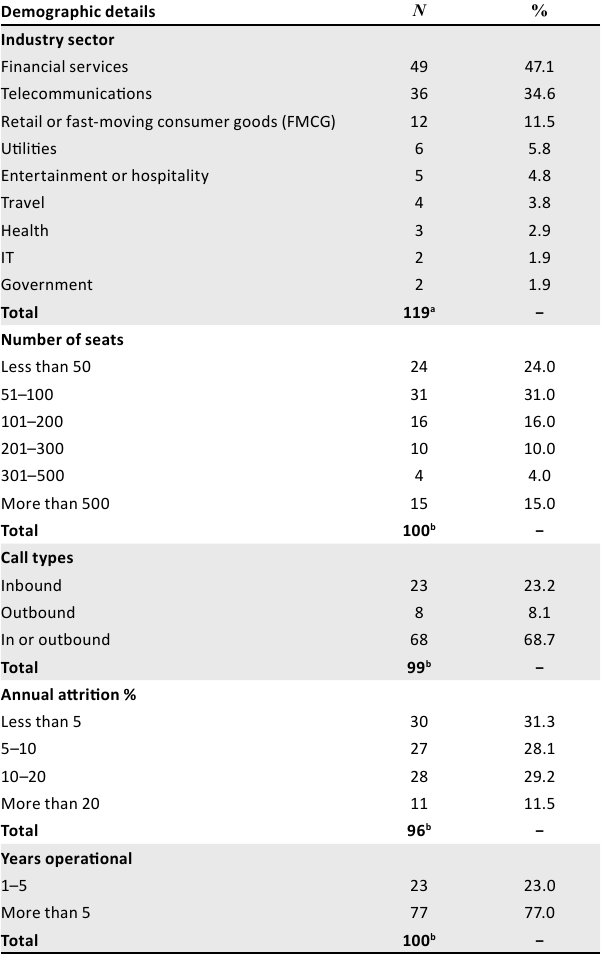
TABLE 1: Demographic details of participating call centres.